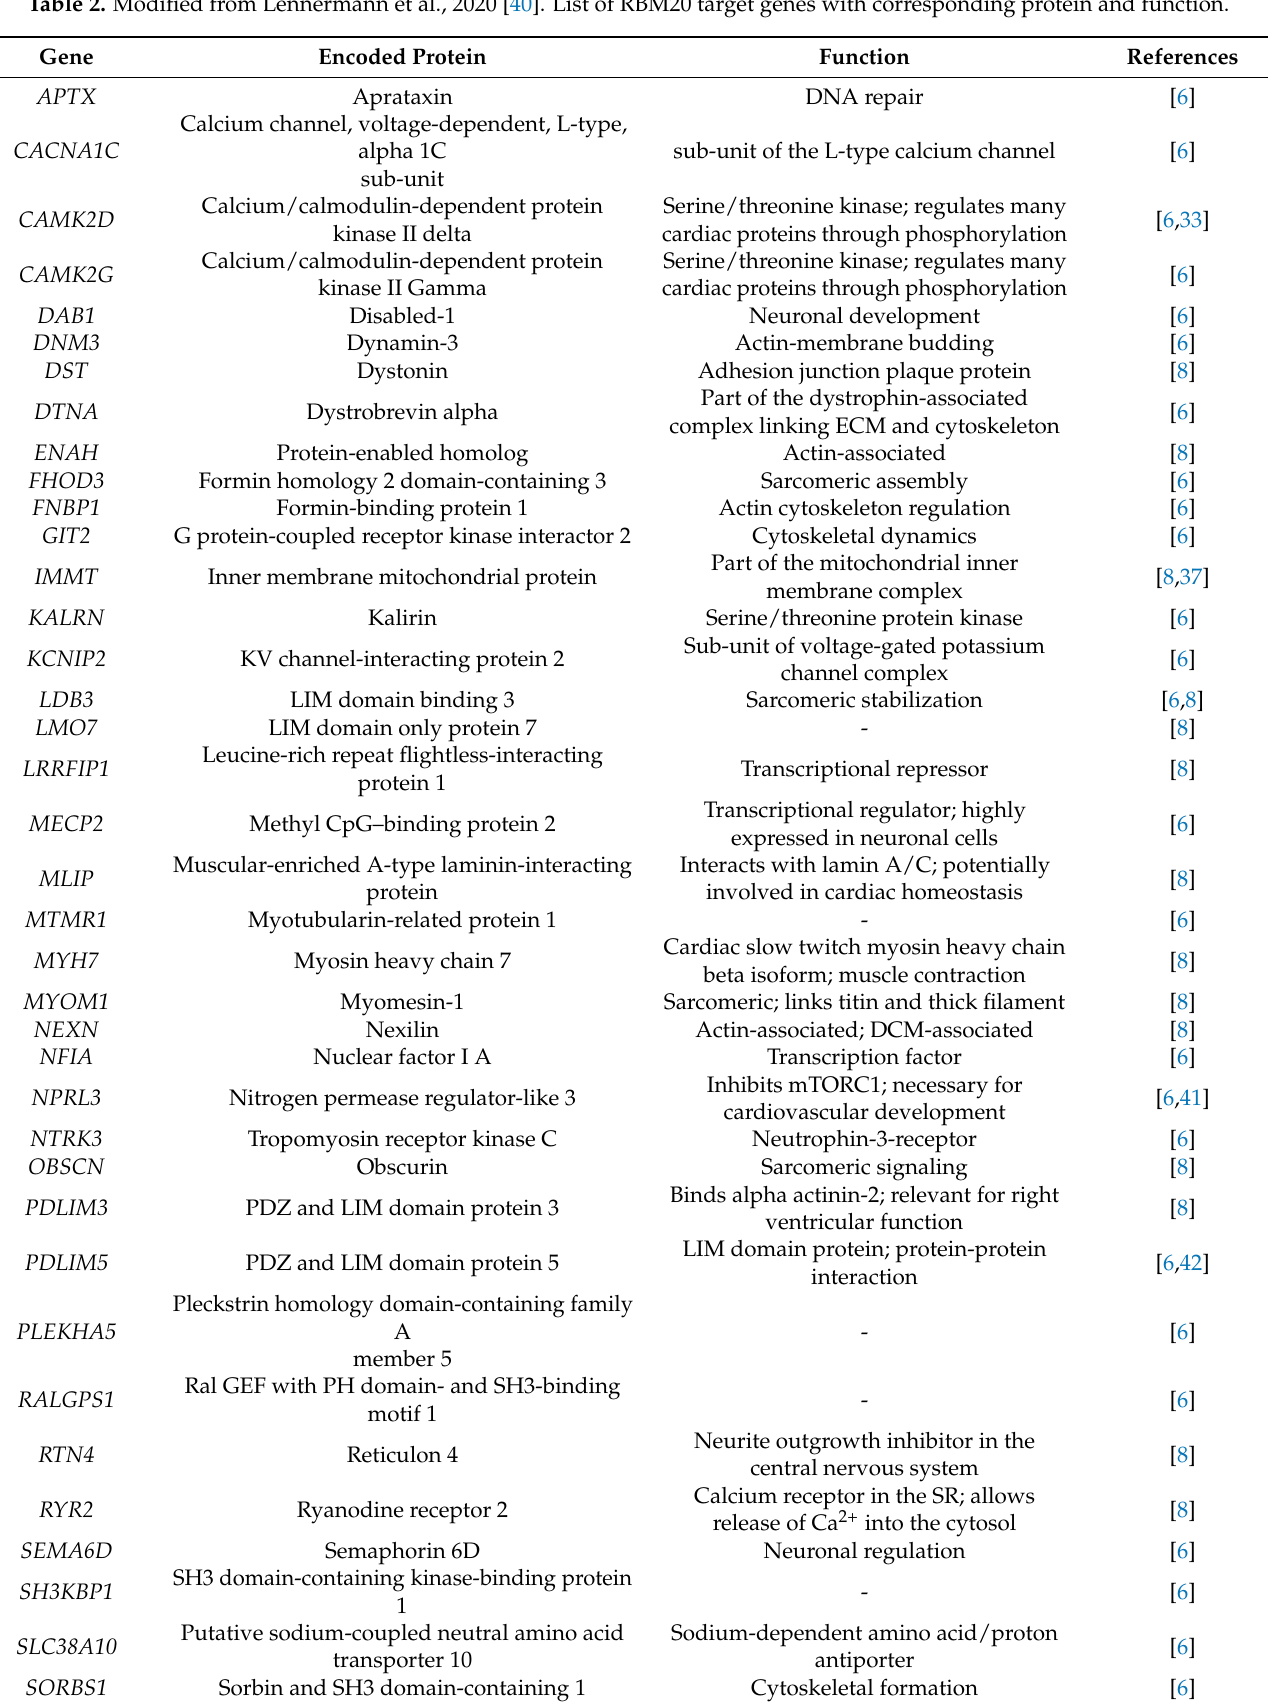
Table 2. Modified from Lennermann et al., 2020 [40]. List of RBM20 target genes with corresponding protein and function.